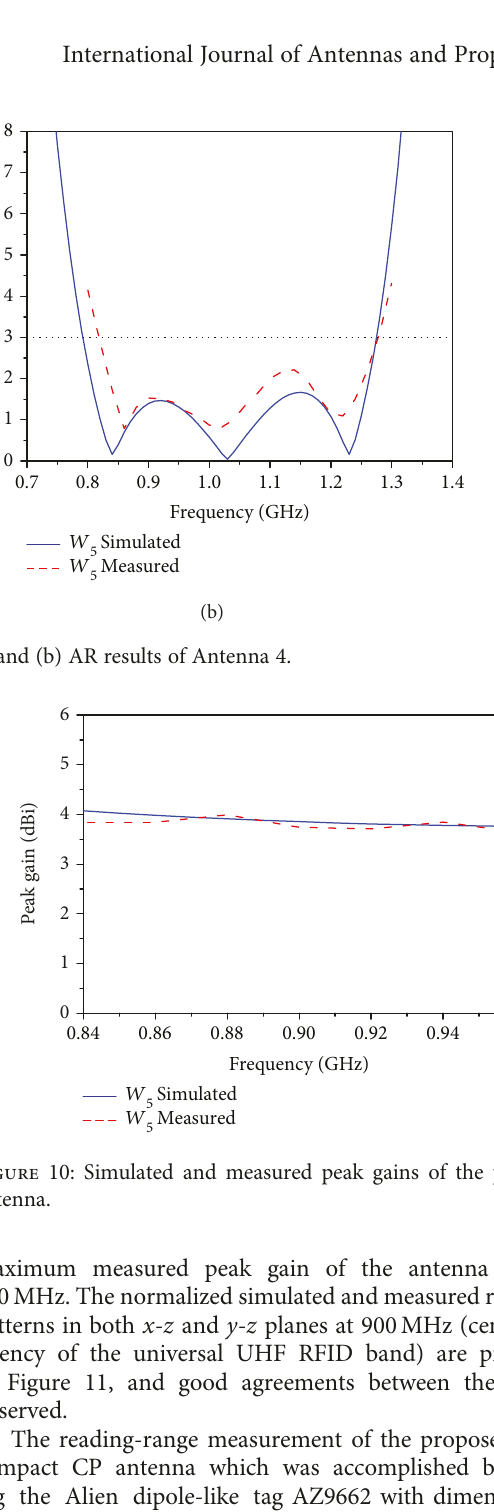
Figure 10: Simulated and measured peak gains of the proposed